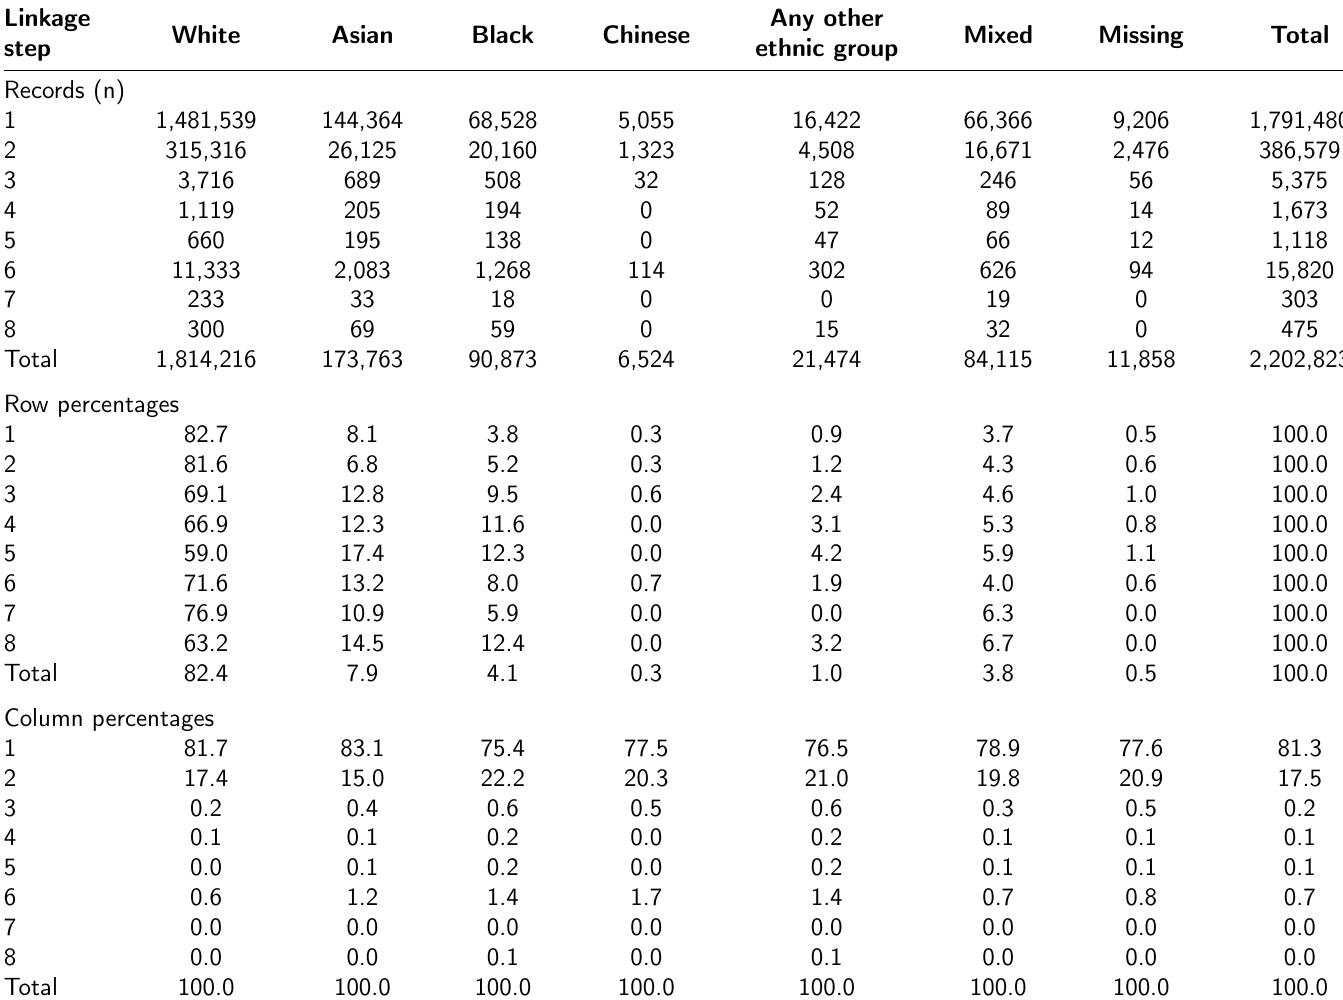
Supplementary Table 7.2: Linkage personal demographics service to hospital episode statistics by linkage step and ethnicity (all